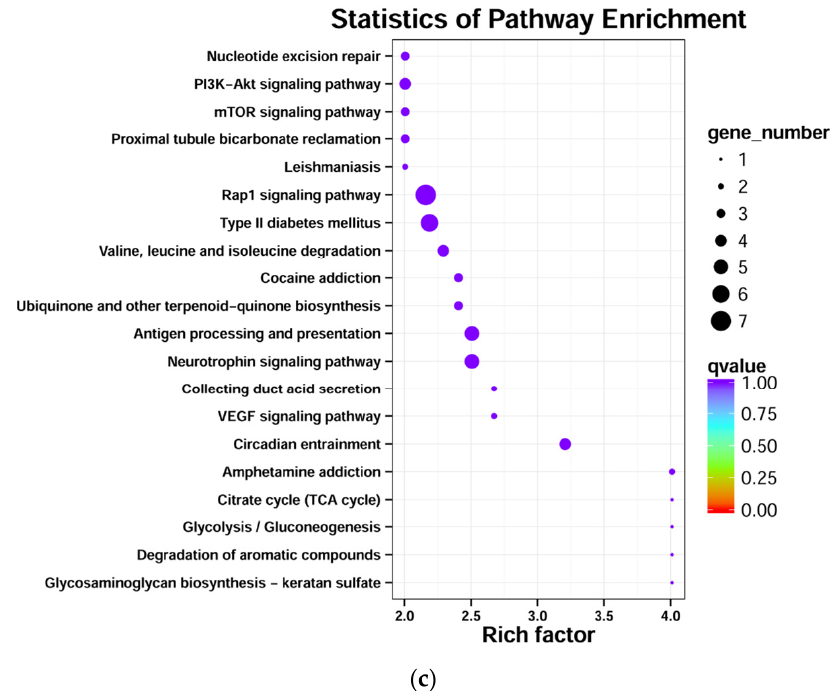
Figure 5. KEGG pathway enrichment of target genes for DEMs in different comparison groups. ( a ) KEGG pathway enrichment of target genes for DEMs in d30 vs. d60; ( b ) KEGG pathway enrichment of target genes for DEMs in d30 vs. d90; ( c ) KEGG pathway enrichment of target genes for DEMs in d60 vs. d90.